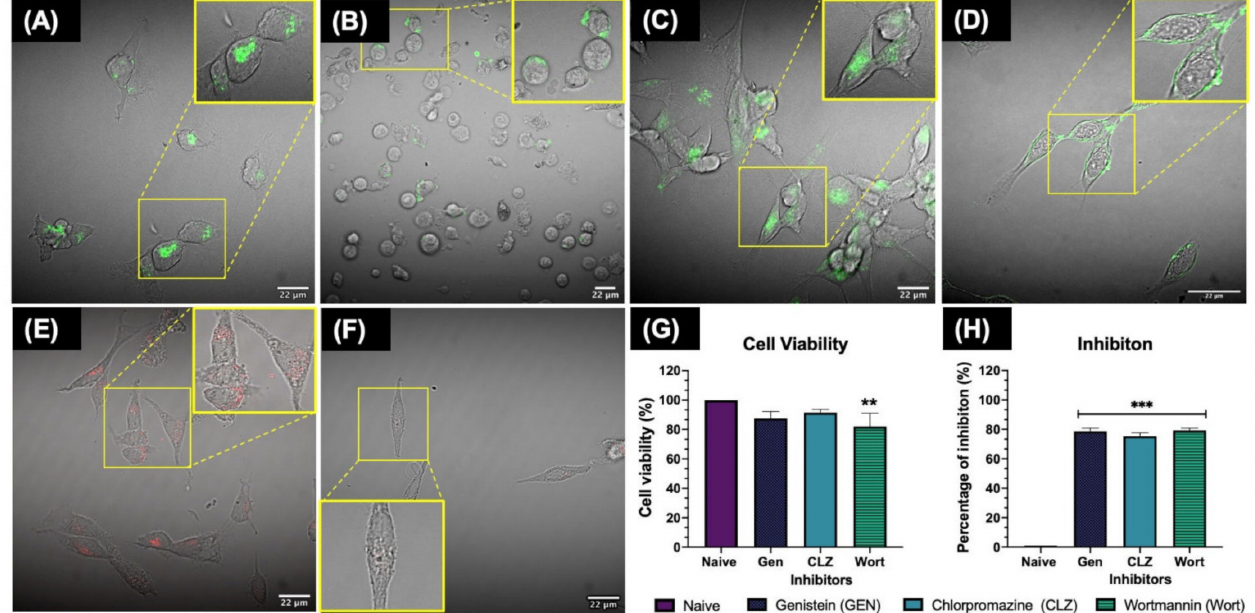
Figure 4. Inhibition of the cellular uptake pathways. ( A ) Uptake of cholera toxin b (control); ( B ) Almost complete reduction of cholera toxin b uptake following inhibition of the caveolae pathway with Genistein at 100 µ g/mL for 20 min. ( C ) Uptake of transferrin (control); ( D ) Reduction of transferrin uptake by the clathrin-mediated pathway after treatment with 10 µ g/mL chlorpromazine for 30 min; ( E ) Uptake of dextran (control); ( F ) Almost complete reduction in uptake of dextran by the macropinocytosis and phagocytosis pathways after treatment with 10 µ g/mL wortmannin for 10 min. All the controls were incubated for 2 h after the addition of the chemical inhibitor. ( G ) Cell viability (%) assessed by LDH assay after treatment with the selected inhibitor concentrations and incubation period. ( H ) The percentage of inhibition calculated for the inhibitor images against their controls. Three individual replicates were performed for each experimental condition and analysis. Images were taken with a 60 × objective lens using a NIKON A1R 808 microscope (Nikon, Tokyo, Japan). Data with asterisks (*) indicate a statistically significant difference (** p < 0.01 and *** p < 0.001) compared to the naive